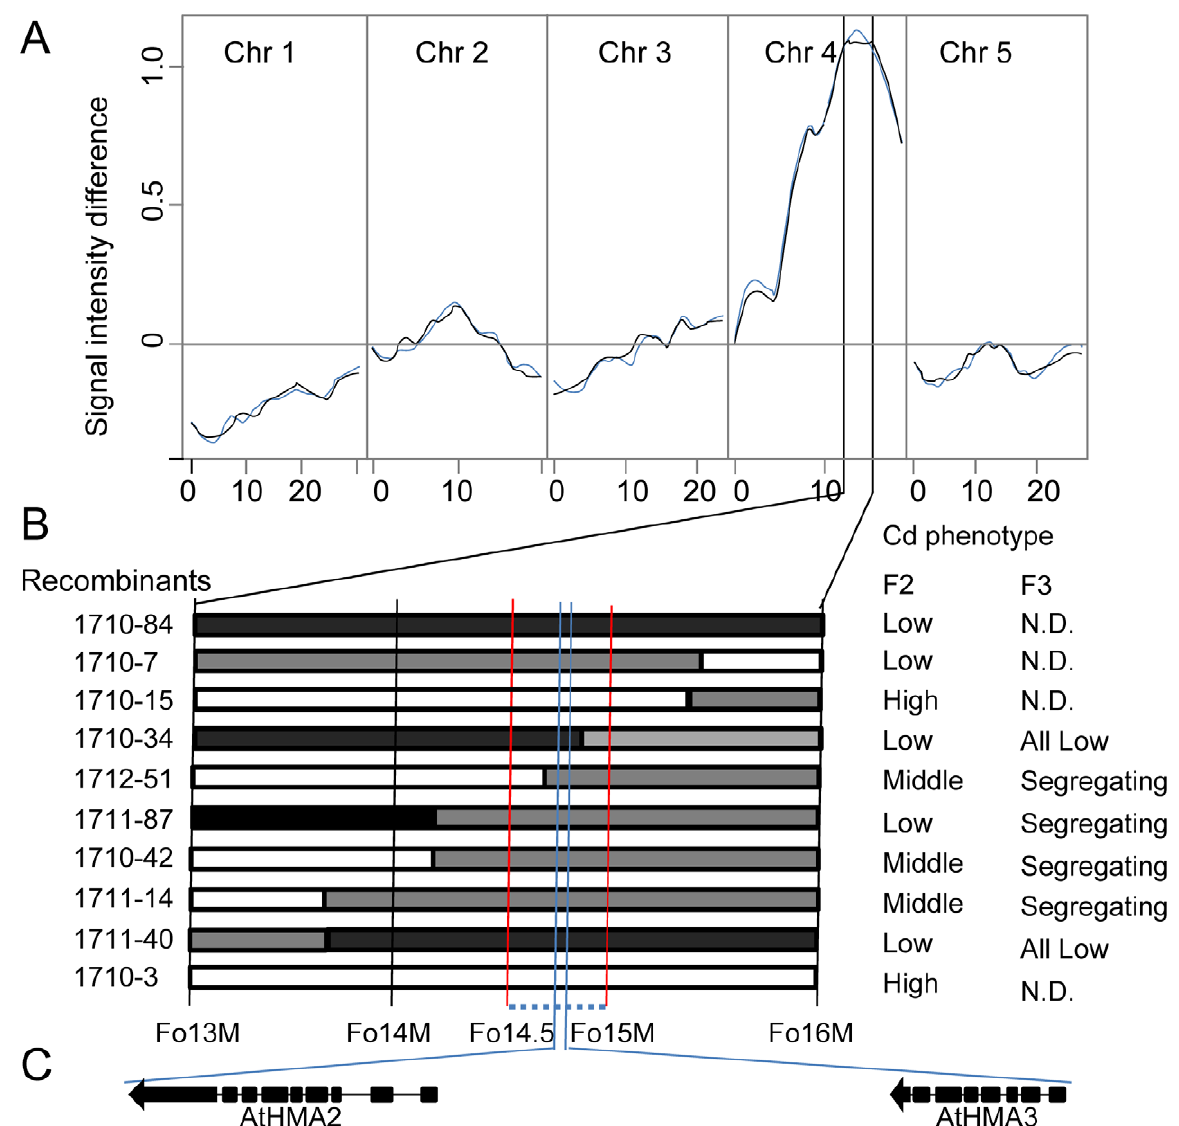
Figure 3. Genetic linkage mapping of the low leaf Cd locus in A.thaliana accession CS28181. A. DNA microarray-based bulk segregant analysis of the low leaf Cd phenotype of CS28181 using phenotyped F2 progeny from a CS28181 6 Col-0 cross genotyped using the 256K AtSNPtilling microarray. Lines represent allele frequency differences between high and low leaf Cd pools of F2 plants at SNPs known to be polymorphic between CS28181 and Col-0 (black line=sense strand probes, blue line=antisense strand probes). B. Fine mapping localizes the causal gene to a 500 kb interval between markers Fo14.5M and Fo15 indicated by the red vertical lines. Black bars represent the CS28181 genotype, grey bars represent heterozygous genotypes and white bars represent Col-0 genotype. Recombinants were selected from 317 CS28181 6 Col-0 F2 plants. Leaf Cd concentration was determined in the F2 and/or the F3 generation. C. Localization and gene structure of HMA2 and HMA3 in the mapping interval. Black bars indicate exons and black lines indicate